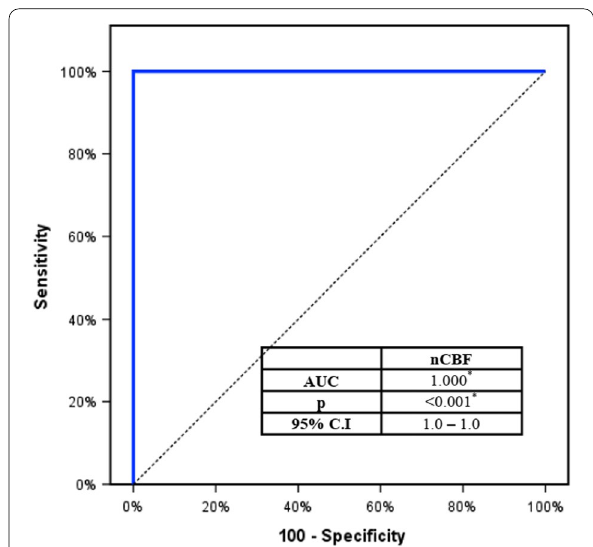
Fig. 9 ROC curve for nCBF > 1.6 to predict hypervascular